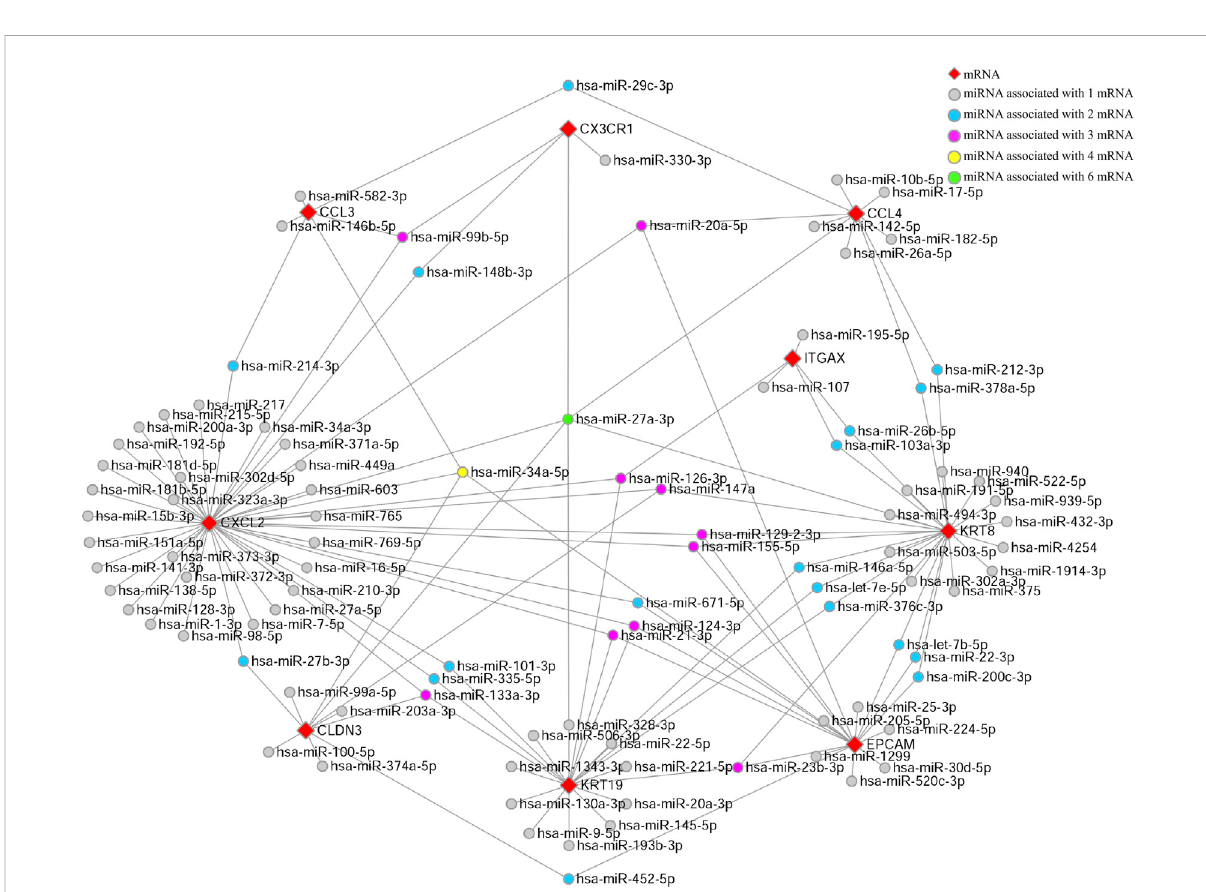
FIGURE 5 miRNA-mRNA-co-expressed network. A co-expressed network of mRNAs and target miRNAs. The mRNA – miRNA co-expressed network was constructed by Cytoscape including 107 nodes and 144 edges. Every node represents one miRNA/mRNA, and each edge represents the interaction of mRNA and miRNA. mRNAs and miRNAs are indicated with diamond and circle shapes,